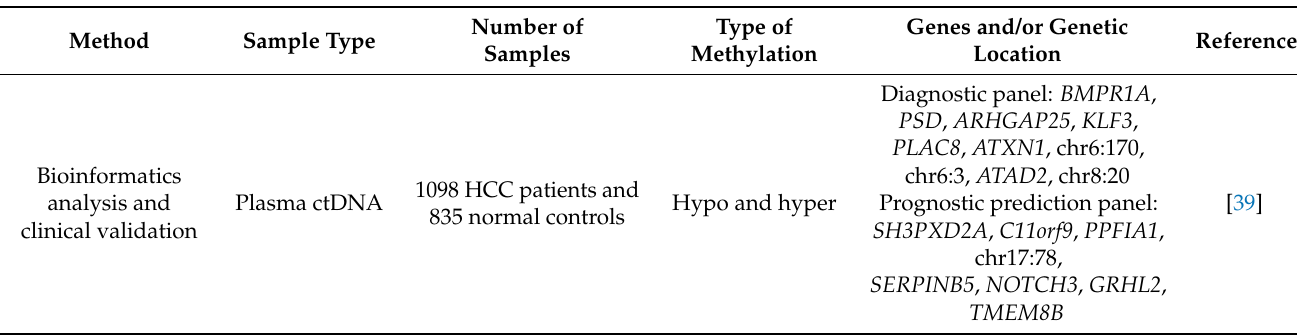
Table 1. An overview of methylation biomarkers for HCC in liquid biopsy. HCC: hepatocelular carcinoma; ctDNA: circulating tumor DNA; cfDNA: cell-free DNA; HM450k: Infinium Human- Methylation450k BeadChip Array; PCR: polymerase chain reaction; MCTA-Seq: methylated CpG tandems amplification and sequencing; TELQA: quantitative allele-specific real-time target and signal amplification assays; MSP: methylation-specific polymerase chain reaction; MSRE-qPCR: methylation-sensitive restriction enzymes-based quantitative PCR; MS-HRM: methylation-sensitive high-resolution